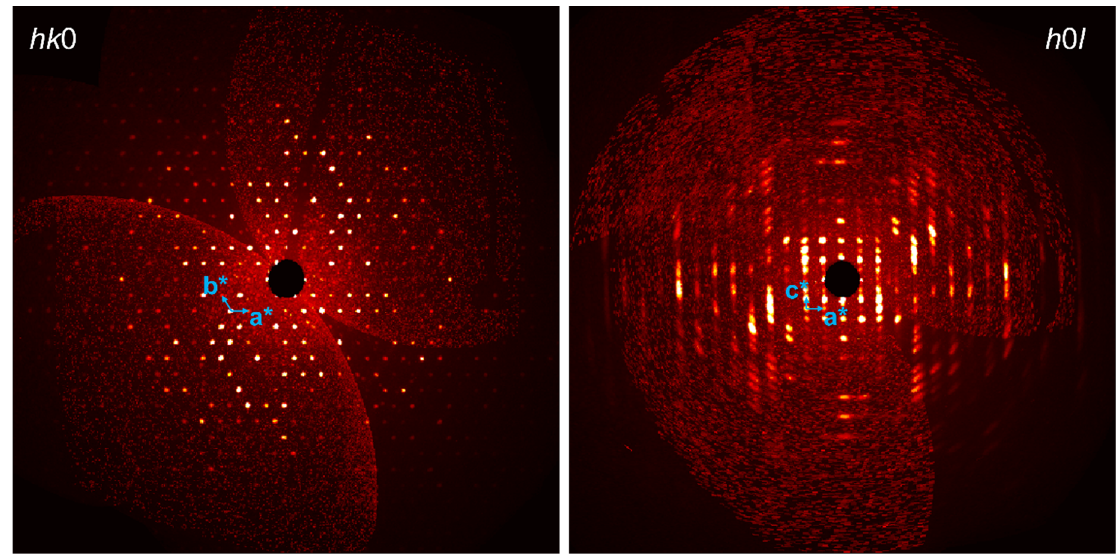
Figure 1. Reconstructed precession images of hk 0 and h 0 l reciprocal lattice layers of the studied crystal.